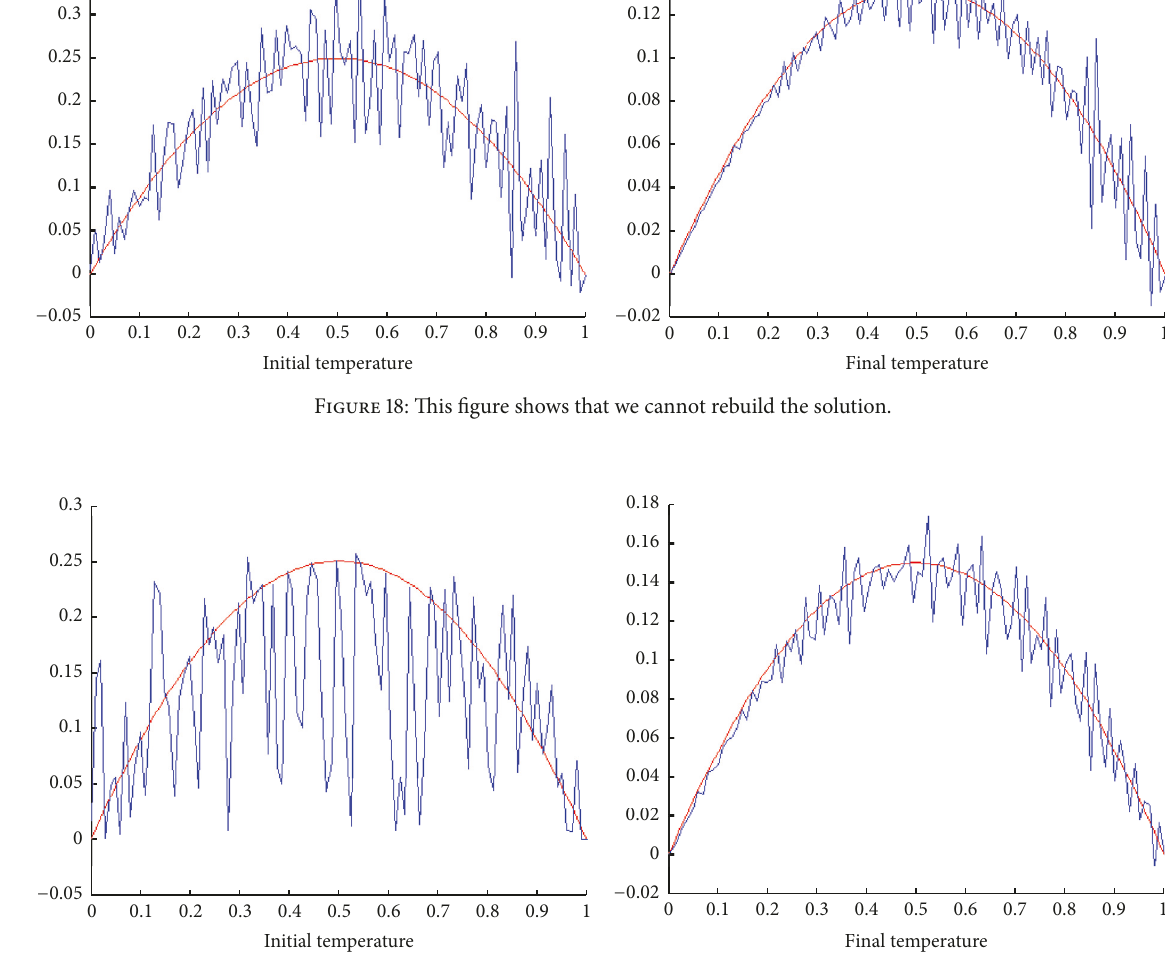
Figure 19: This figure shows that we cannot rebuild the solution.